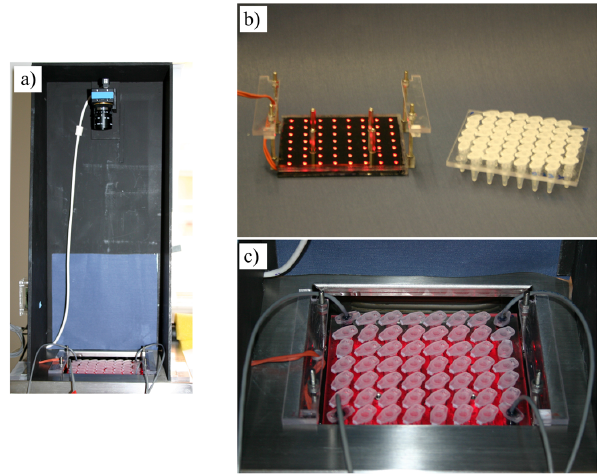
Fig. 1. (a) Cold bath set-up, ready for analysis with camera record- ing from above; (b) LED array and polycarbonate plate holding 52 sample tubes; (c) detail of tubes and Pt 1000 sensors in the corners of the grid inside the cooling bath.